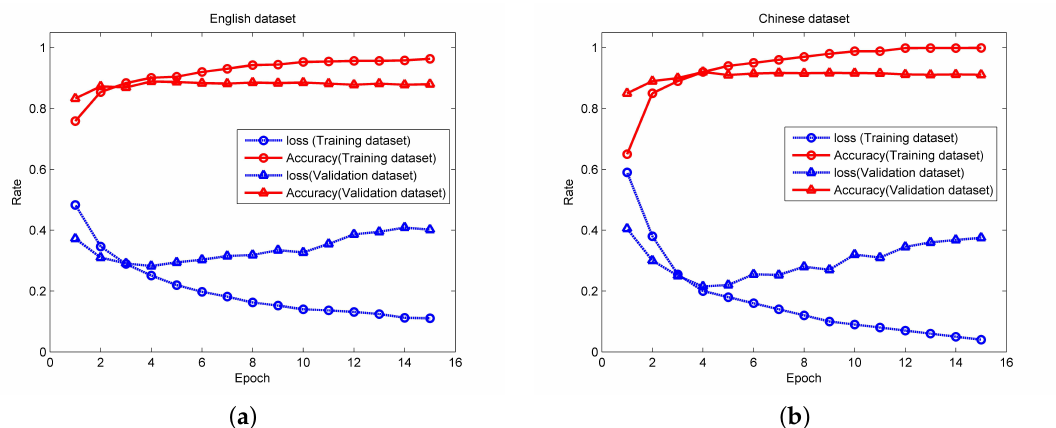
Figure 6. Performance test with the increase of epoches for the proposed model. ( a ) English dataset. ( b ) Chinese